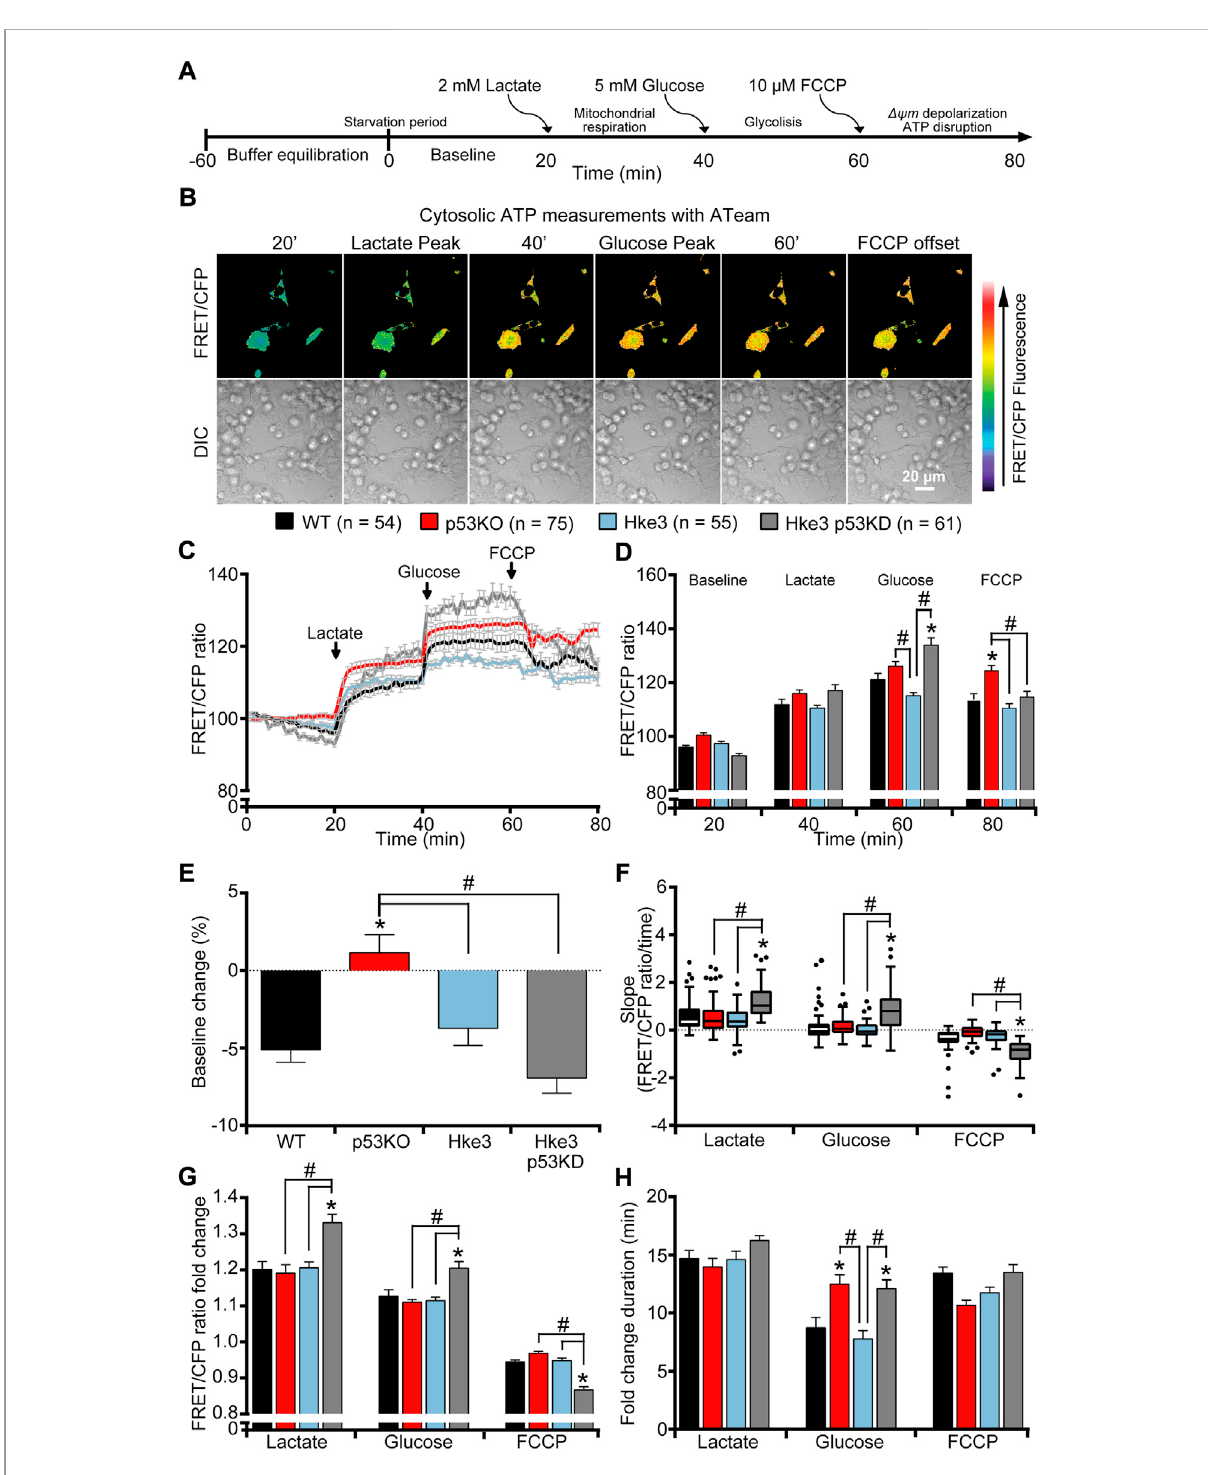
FIGURE 1 TP53 -silenced Hke3 cells with a competent KRAS gene display signi fi cantly increased cytosolic ATP kinetics in response to extracellular substrates addition. WT, p53 KO, Hke3 and Hke3 p53 KD HCT-116 cells were separately transfected with the cytosolic ATP-sensitive (ATeam) FRET probe, loaded with 30 nM TMRM as a Δ ψ m indicator (non-quenched mode), mounted on the heated stage of an LSM 710 confocal microscope and assayed over 80 min at 37 ° C. (A) Experimental model schematic. C ells were allowed to equilibrate for 60 min on stage (starvation period), after which alterations in Δ ψ m and cytosolicATP weremonitored insinglecells. Following abaseline of20min,cellswereexposedto sequential additions of 2 mM lactate, 5 mM glucose and 10 µM FCCP at the indicated time points (20, 40 and 60 min) to promote mitochondrial respiration, glycolysis